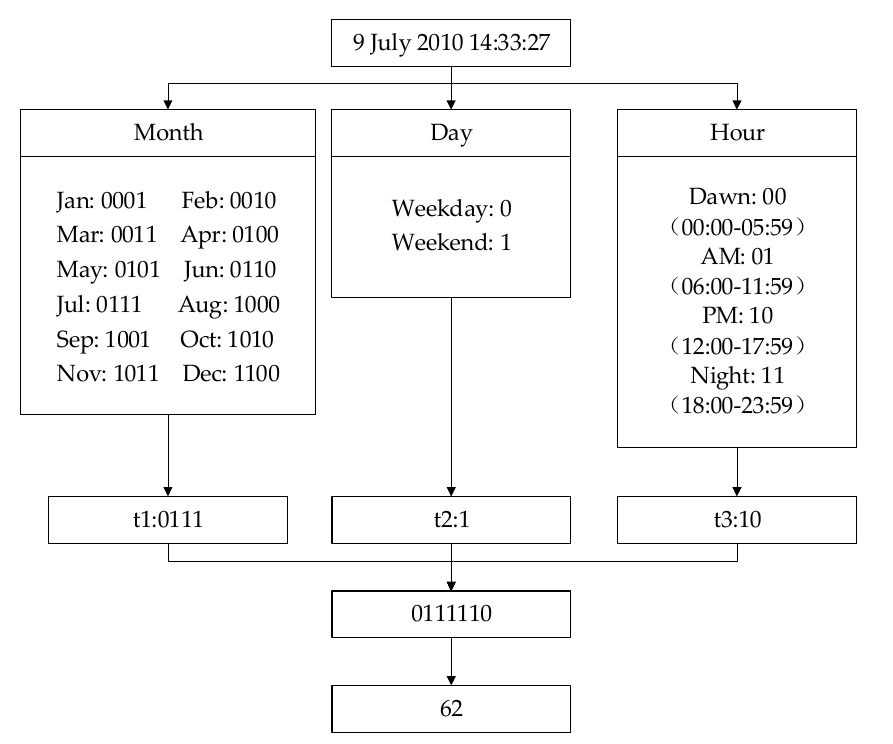
Figure 3. Time slot encoding illustration (96 time